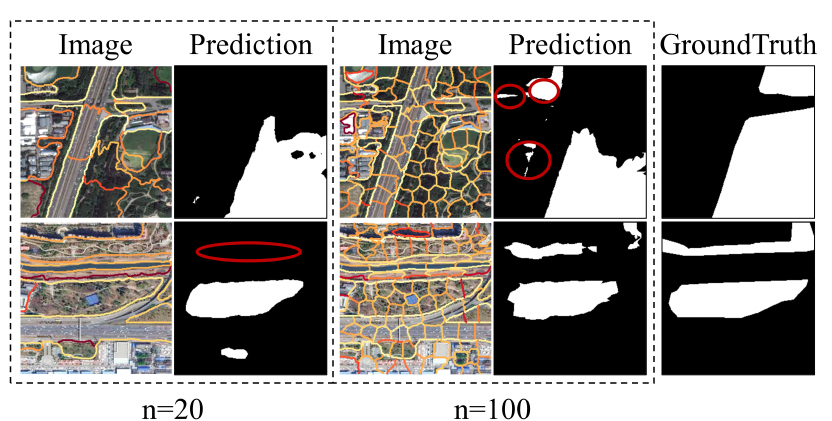
Figure 10. Comparison of qualitative results at different segmentation scales. Segmentation results of different segmentation scales are placed on the image. Predicted differences are marked with red